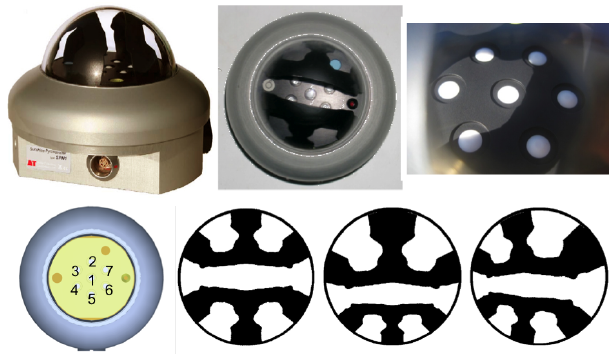
Figure 1. Top row: different SPN1 views; photo on the right shows a shadow pattern on the seven sensors for a particular sunny moment. Bottom row: SPN1 detector numbering; sky seen under shade pat- terns as seen for sensor 1 (left), sensors 2 and 5 (middle) and sensors 3 , 4 , 6 , 7 (right). Sources: Long et al. (2010) and Delta-T Devices Ltd.